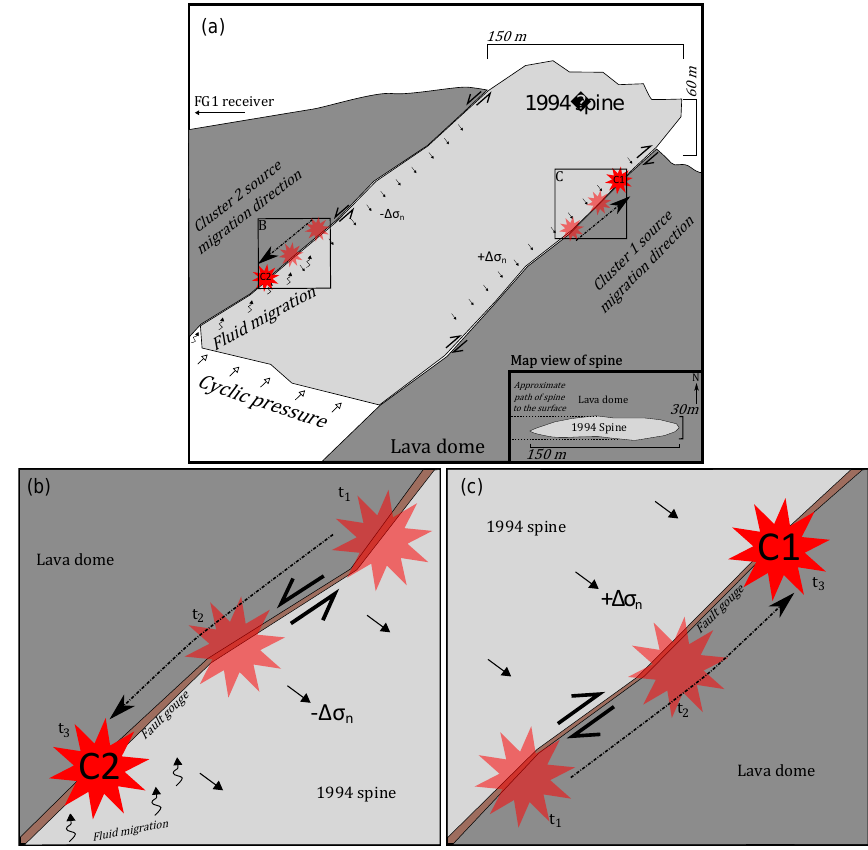
Figure 6. (a) An E–W cross section of the conceptual model for spine extrusion and cluster source locations at Unzen volcano in Octo- ber/November 1994, looking north. The inset shows a map view of the spine at the surface of the lava dome. Squares indicate the locations of (b) and (c) . (b) Detailed view of the source region for cluster 2, showing how it moves progressively deeper over time ( t 1 , t 2 , t 3 ) in response to the decrease in normal stress. (c) Detailed view of the source region for cluster 1, showing how it moves progressively shallower over time ( t 1 , t 2 , t 3 ) in response to the increase in normal stress. Please see Sect. 4.4 for more details and